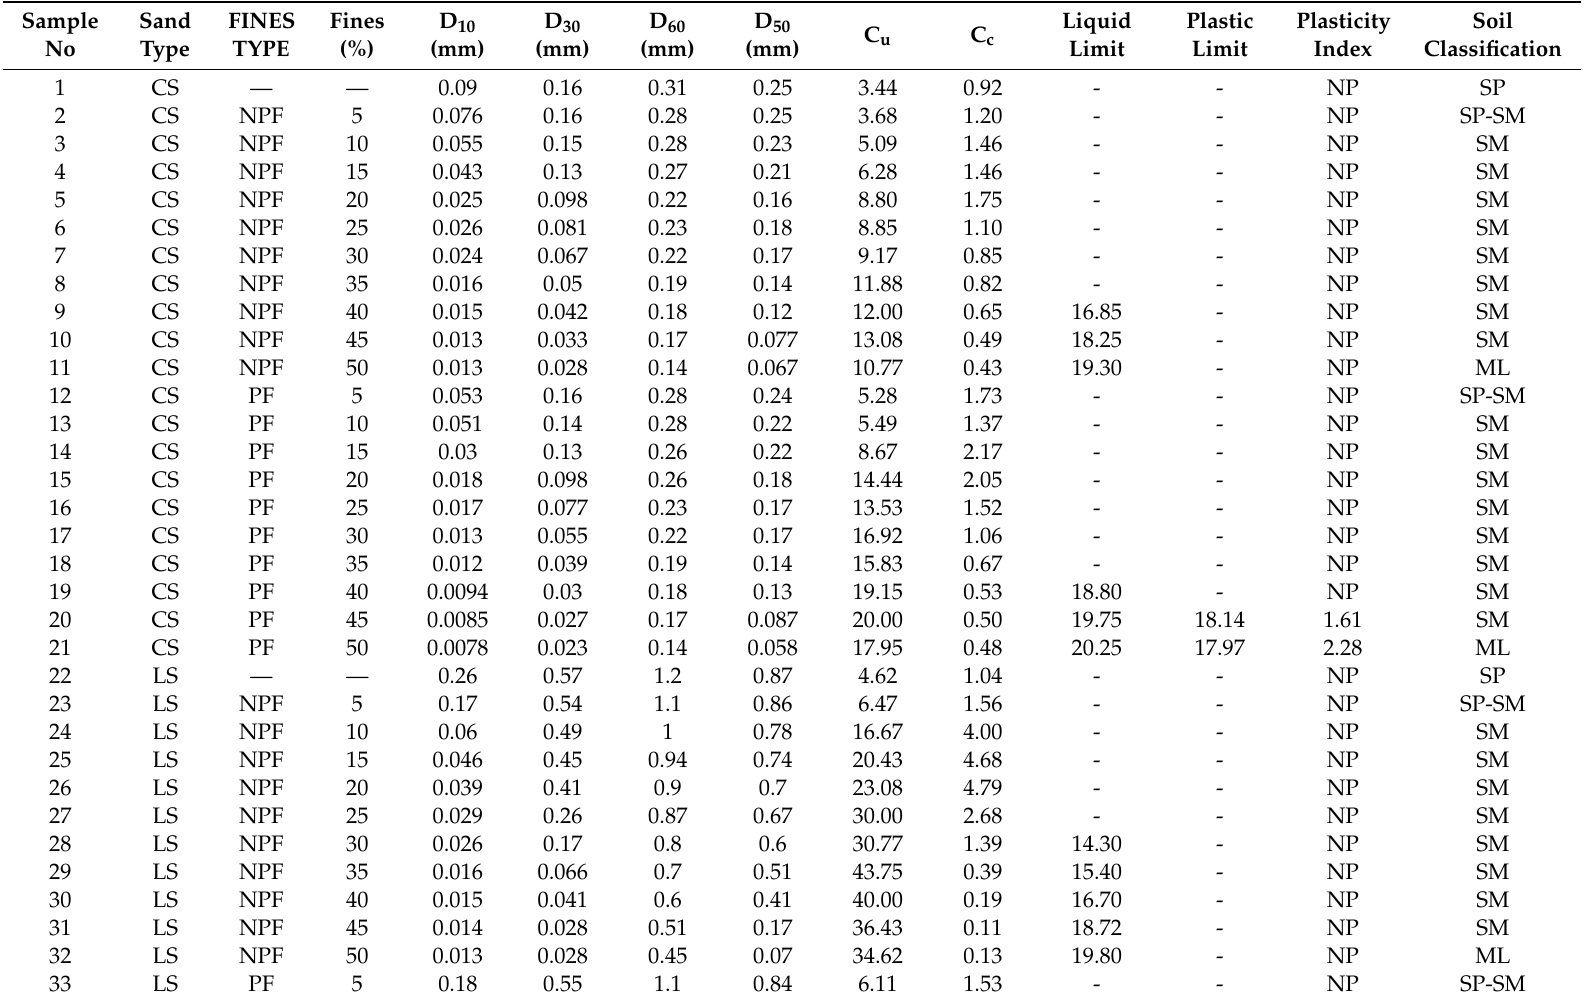
Table 1. Data from gradation curves, consistency limits and soil symbols of all the